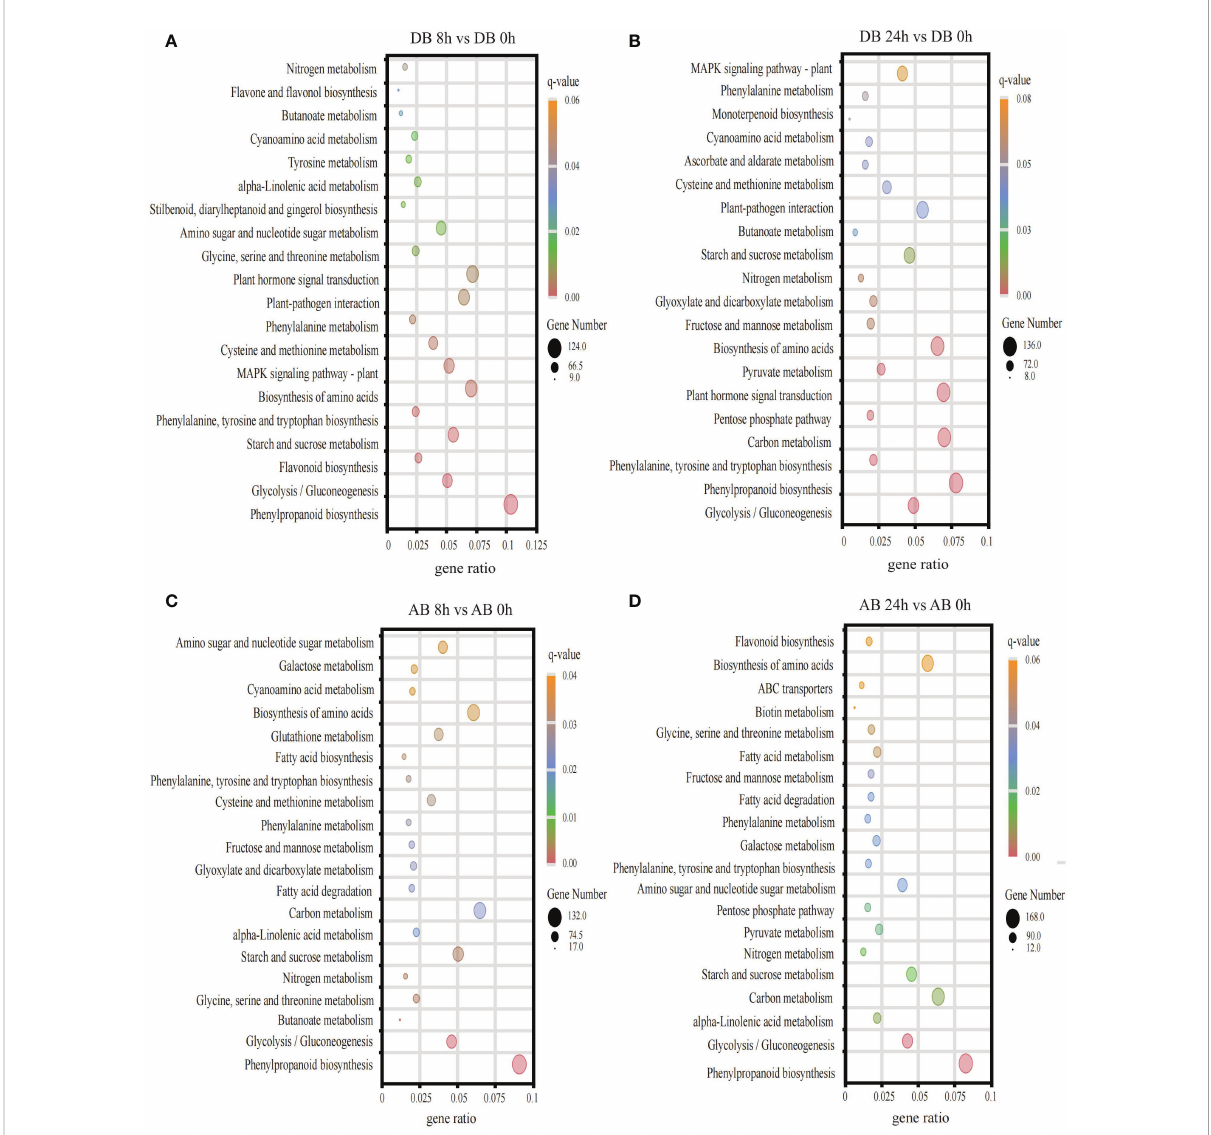
FIGURE 5 The KEGG pathway enrichment analysis. (A) DB 8 h vs DB 0 h (B) DB 24 h vs DB 0 h (C) AB 8 h vs AB 0 h (D) AB 24 h vs AB 0 h The ordinate indicates metabolic pathway, while the abscissa indicates the gene ratio. The size of the dot indicates the number of DEGs in the pathway, while the color indicates the different